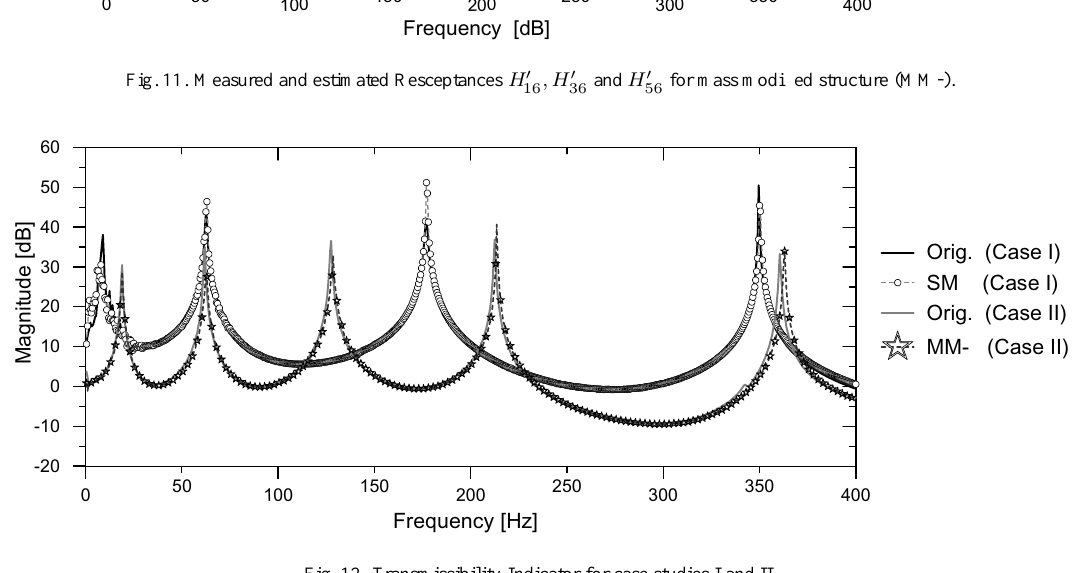
Fig. 12. Transmissibility Indicator for case studies I and